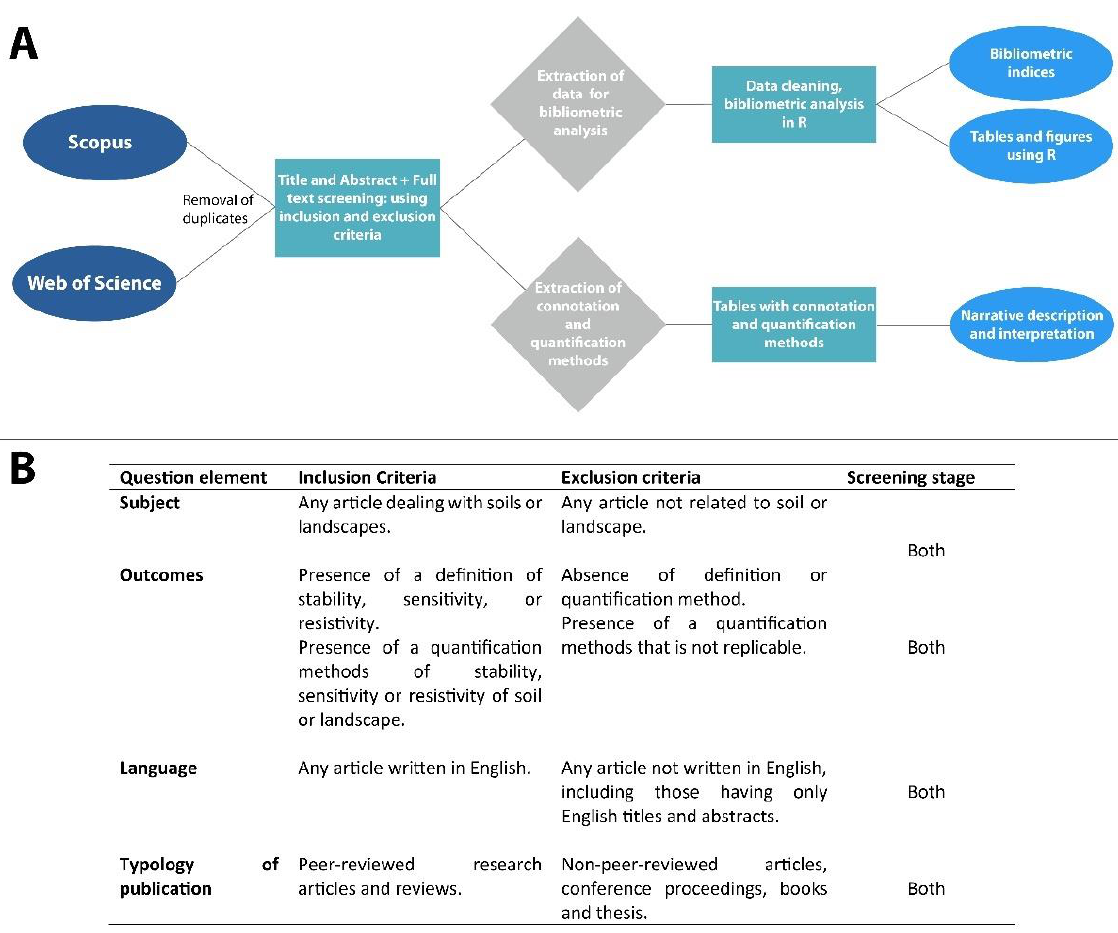
Figure 1. ( A ) General Workflow. ( B ) Inclusion and exclusion criteria used during the screening process.